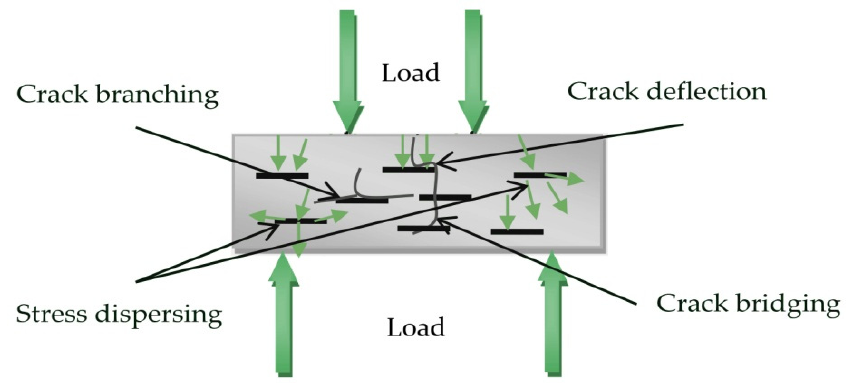
Figure 9. GNPs action under 4 - point bending load.